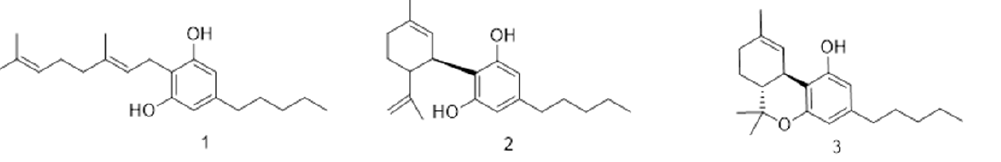
Figure 1. Structure of Cannabigerol (1), Cannabidiol (2), and ∆ 9 -tetrahydrocannabinol (3). NSC-34 cells are hybridoma cells of neuroblastoma and motor neuron-enriched spi-